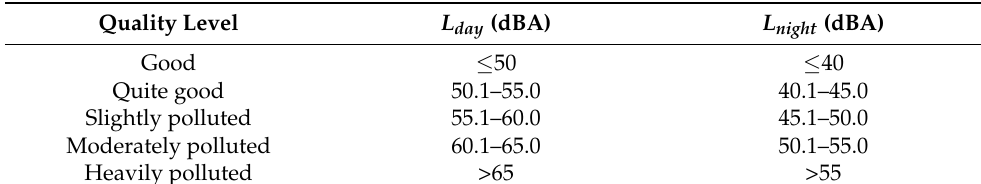
Table A2. Classification of environmental noise quality levels in urban areas [47].